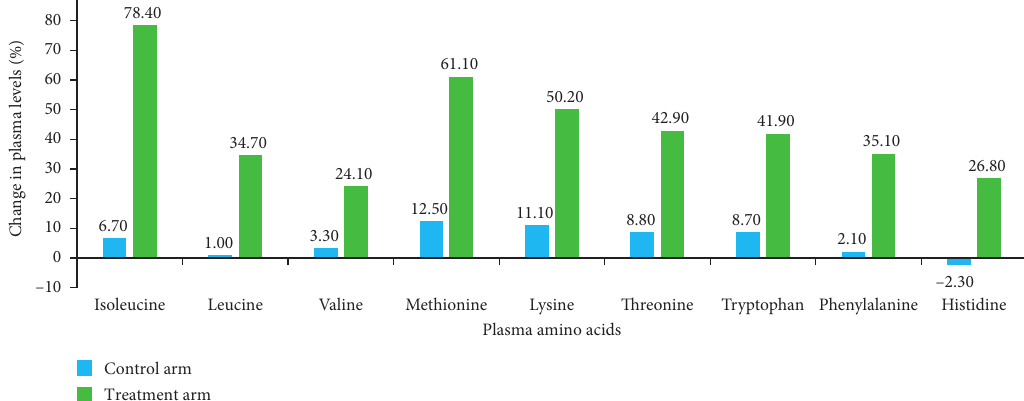
Figure 3: Percentage changes in plasma levels of essential amino acids from baseline to 60min in the treatment and control